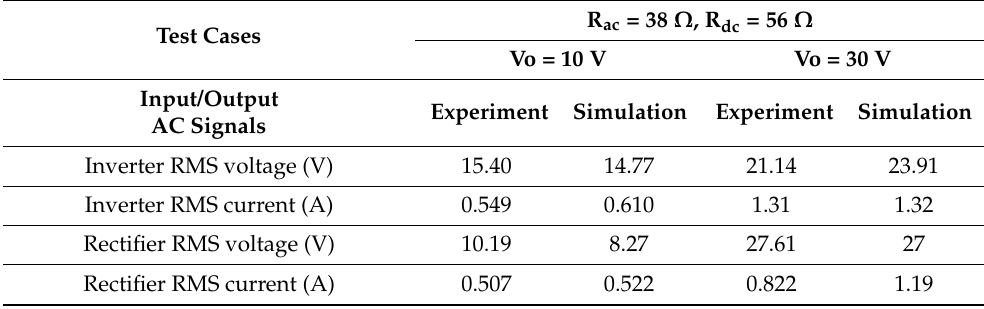
Figure 22. Inverter/rectifier AC voltage and current waveforms at Vo = 30 V, R ac = 38 Ω with R dc = 56 Ω connected. Table 7. DAB inverter/rectifier voltage/current for Vo = 10 V vs. Vo = 30